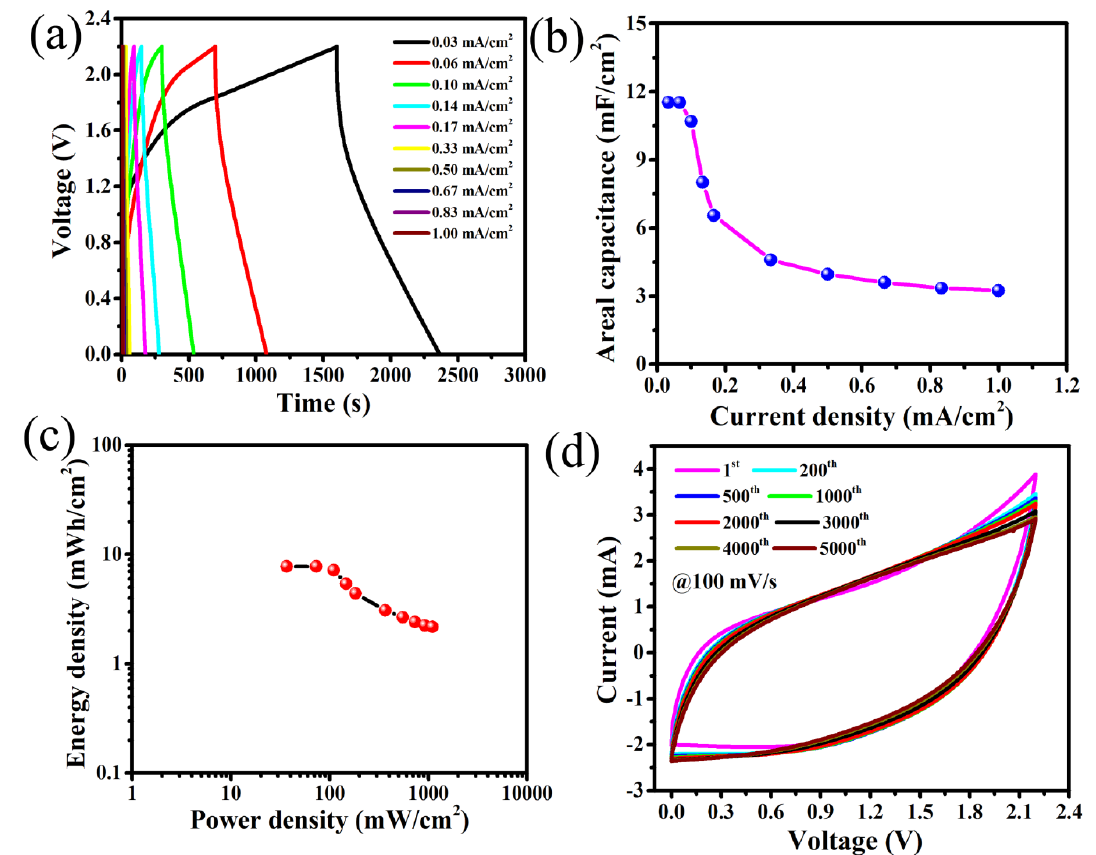
Figure 3. ( a ) Galvanostatic charge–discharge (GCD) at different current densities, ( b ) areal capacitance vs. current density, ( c ) Ragone plot and ( d ) 5000 CV measurements of Mn/MnO x @Graphite electrodes based